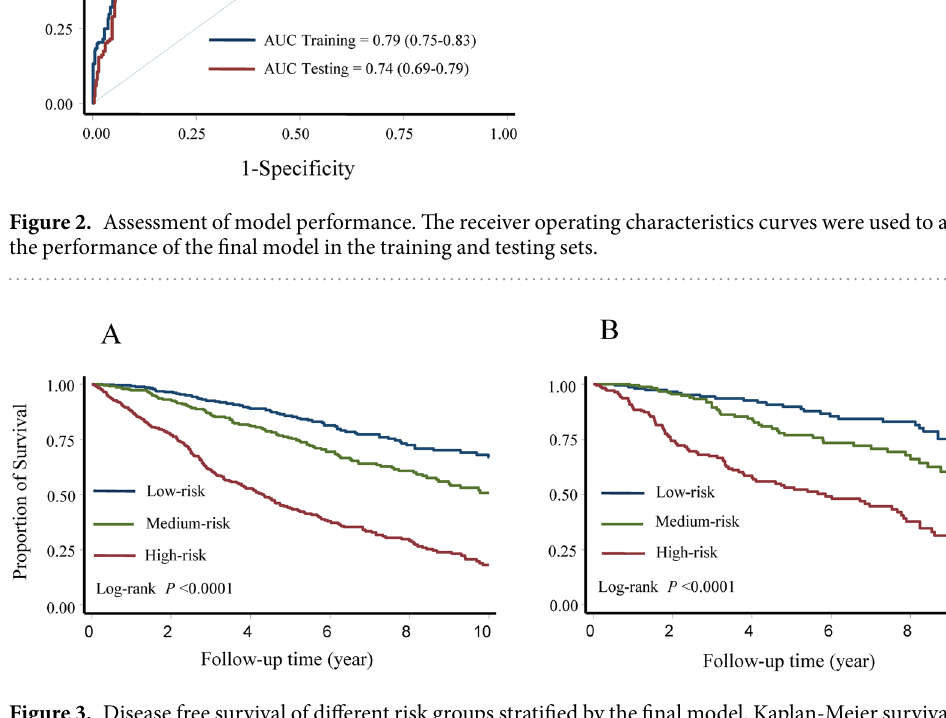
Figure 3. Disease free survival of different risk groups stratified by the final model. Kaplan-Meier survival estimates were used to characterize patients of different risk groups classified by the final model in the training ( A ) and testing ( B )